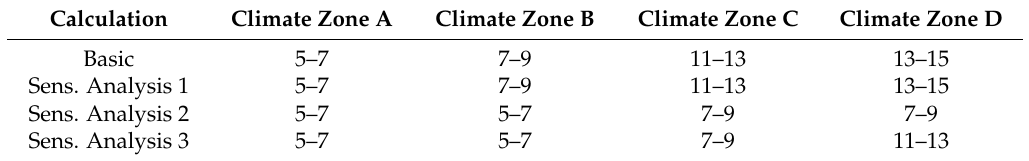
Table 9. Cost-optimal levels of insulation thickness (in cm) for the financial calculations 1 .